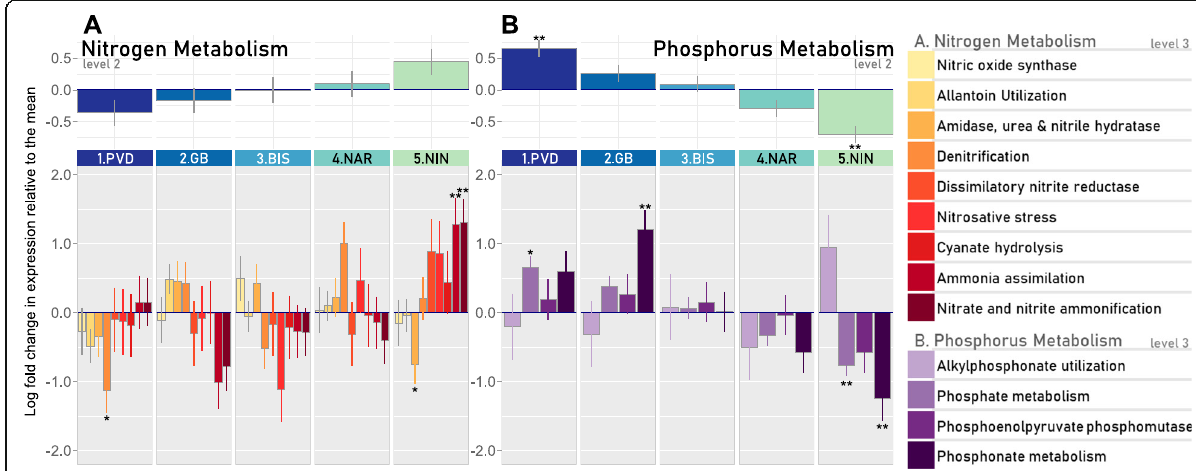
Fig. 6 Differential gene expression in nitrogen and phosphorus metabolism at each site. a Differential expression of Nitrogen pathways at all sites, relative to the mean of the others ( n = 5, Significance: Benjamini-Hochberg * p adj < 0.05, ** p adj < 0.01). (top) Total differential expression of overall nitrogen metabolism, indicated with the blue-green colors. (bottom) Relative log fold change in nitrogen metabolism pathways, indicated with yellow-red colors. b Differential expression of Phosphorus pathways at all sites, relative to the mean. (top) Total differential expression of overall phosphorus metabolism, indicated with the blue-green colors. (bottom) Relative log fold change in phosphorus metabolism pathways, indicated with purple